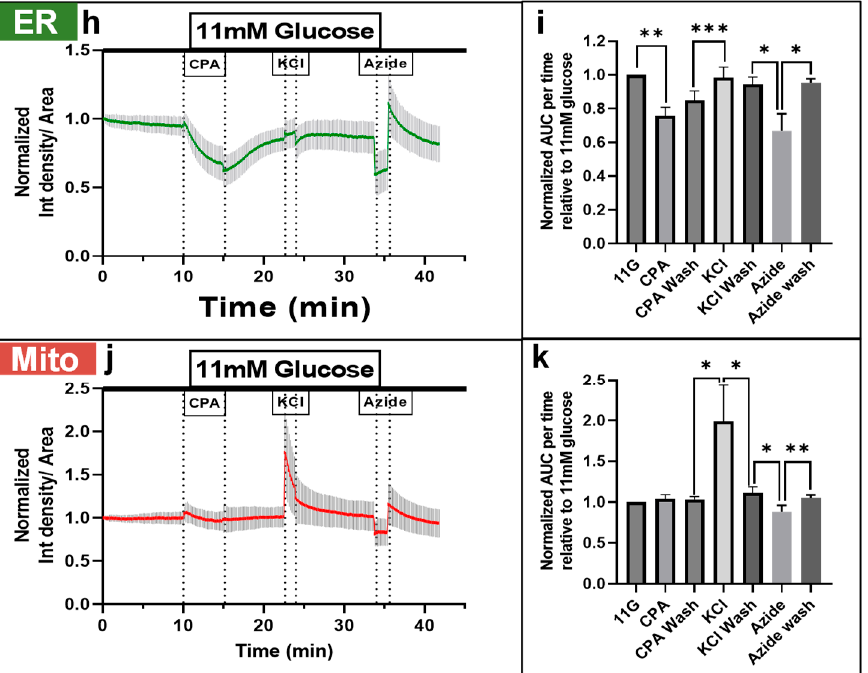
Figure 2. Functional characterization of DS-1 transduced INS1-832/13 cells with agents known to affect ER and mito Ca 2+ . Cells were initially treated with imaging buffer and exchanged with specific agents dissolved in imaging buffer. Live cell images were taken continuously every 10 s during the process. ( a – g ) Snapshot of confocal image for each treatment condition and washes. The complete time series is shown in Movie S1. ( h , j ) Mean ER and mito fluorescent value of all the cells in the field with their standard deviation. The arbitrary fluorescent value of each cell is calculated from ImageJ. ( i , k ) Quantitation of change in fluorescence represented as normalized AUC (area under curve) relative to 11 mM glucose (imaging buffer) for each treatment condition and their statistical summary. * p < 0.1; ** p < 0.05 and *** p < 0.01. Representative ER and mito traces of individual cells are shown in Figure